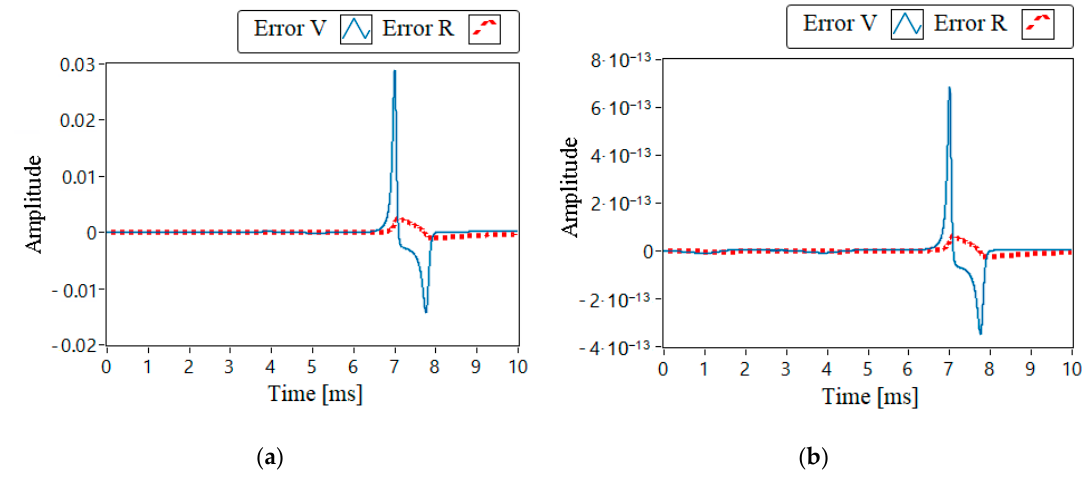
Figure 2. The absolute error of ( a ) 32-bit fixed-point (FXP) and ( b ) 64-bit FXP models compared with that of the double (DBL) model.